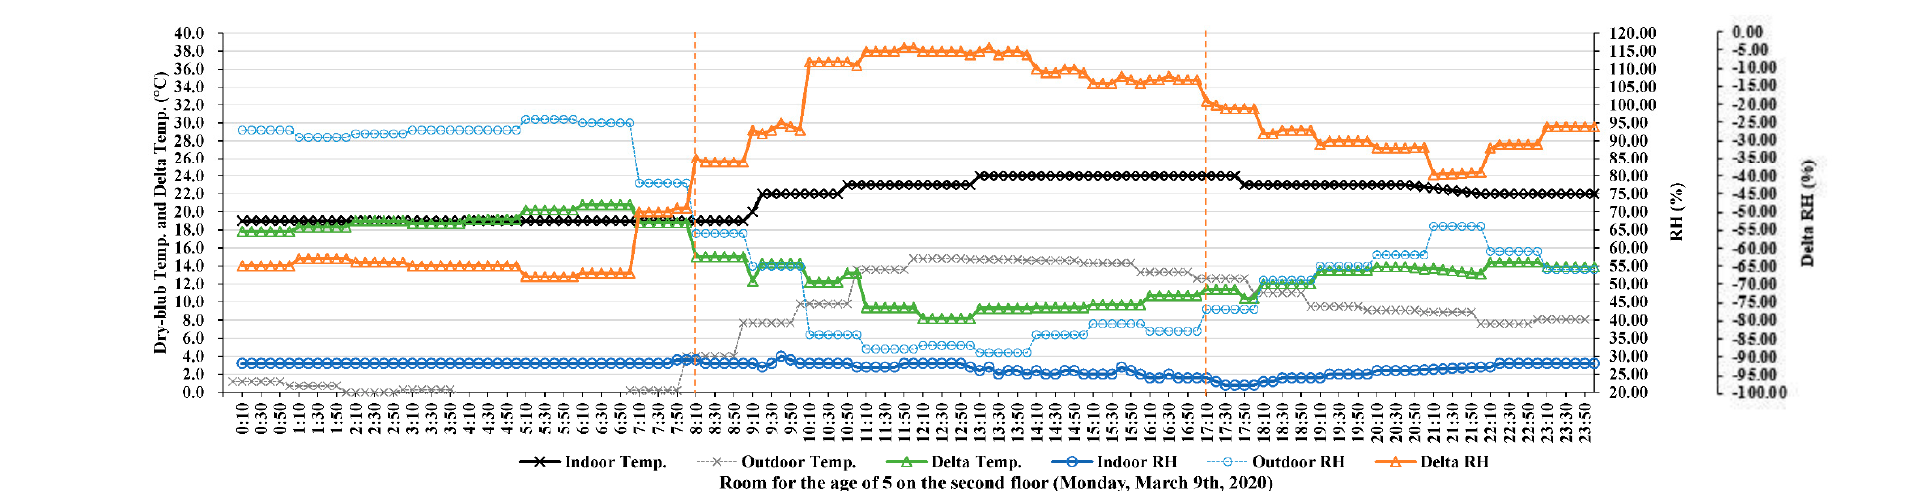
Figure 8. Time-series analysis on the day when the ERV system was on.